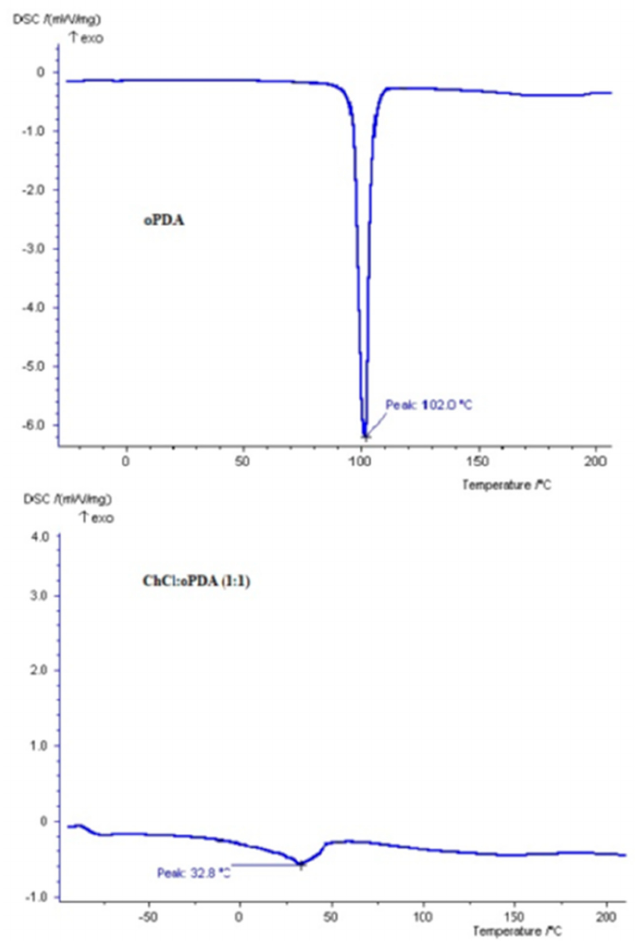
Figure 3. Molecules 2019 , 24 , x FOR PEER REVIEW